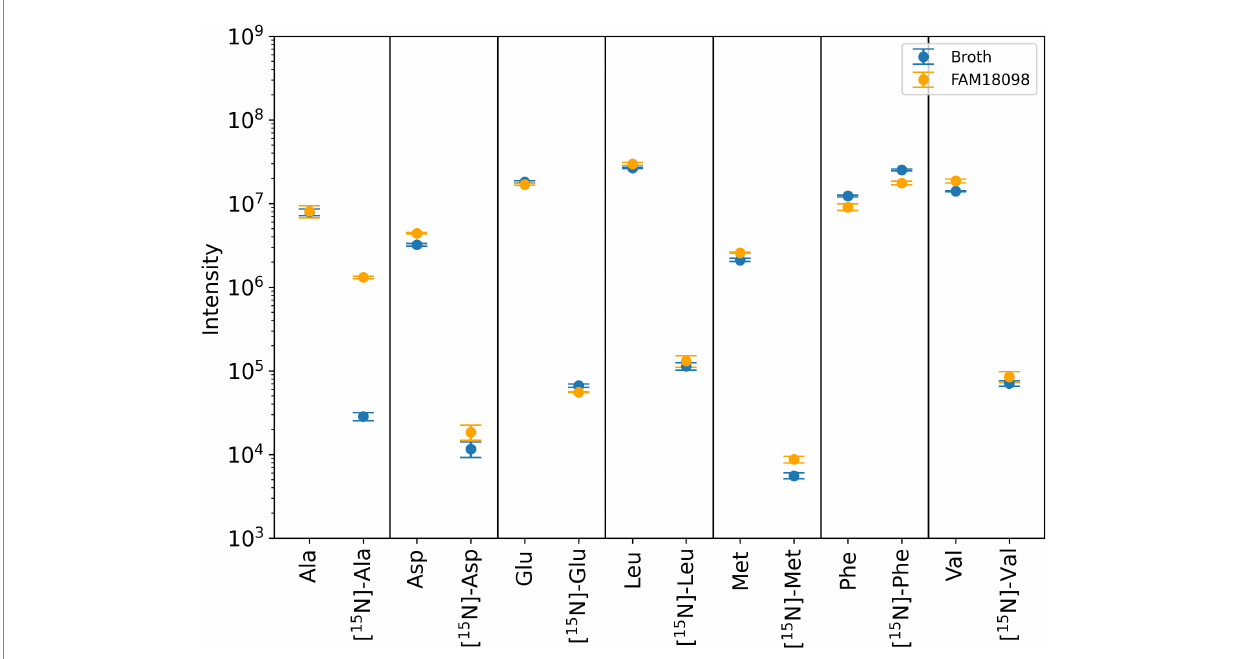
FIGURE 5 Determination of unlabeled and [ 15 N]-labeled amino acids using mass spectrometry. Blue and orange dots represent the values determined in unfermented medium and medium fermented with P. acidilactici FAM 18098, respectively. Values represent the mean of three independent biological experiments (±standard deviation). Ala, alanine; Asp, aspartic acid; Glu, glutamic acid; Leu, leucine; Met, methionine; Phe, phenylalanine; Val, valine.